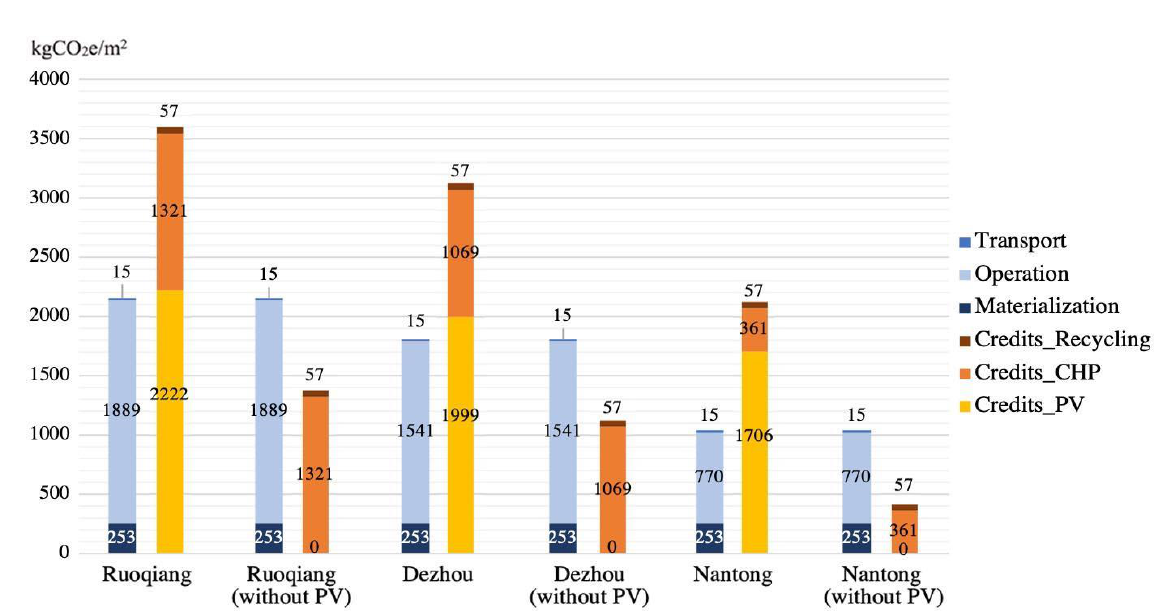
Figure 7 Life-cycle carbon balance of the buildings with or without PV